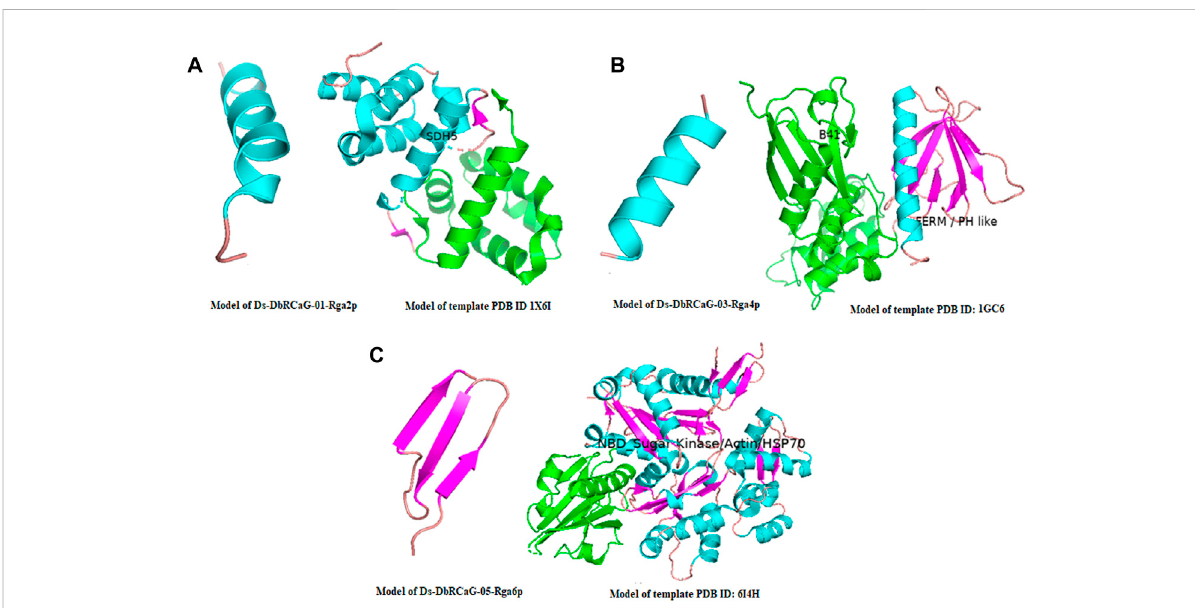
FIGURE 1 3-D imaging of Ds-DbRCaG-01-Rga2p, Ds-DbRCaG-03-Rga4p, and Ds-DbRCaG-05-Rga6p. The homology zone of the template model and the model of predicated protein structure of each identi fi ed RGA showing with same colors: (A) predicted protein structure of Ds-DbRCaG-01- Rga2p, (B) predicted protein structure of Ds-DbRCaG-03-Rga4p, and (C) predicted protein structure of Ds-DbRCaG-05-Rga6p. The secondary models of template proteins were retrieved from the RCSB Protein Data Base,